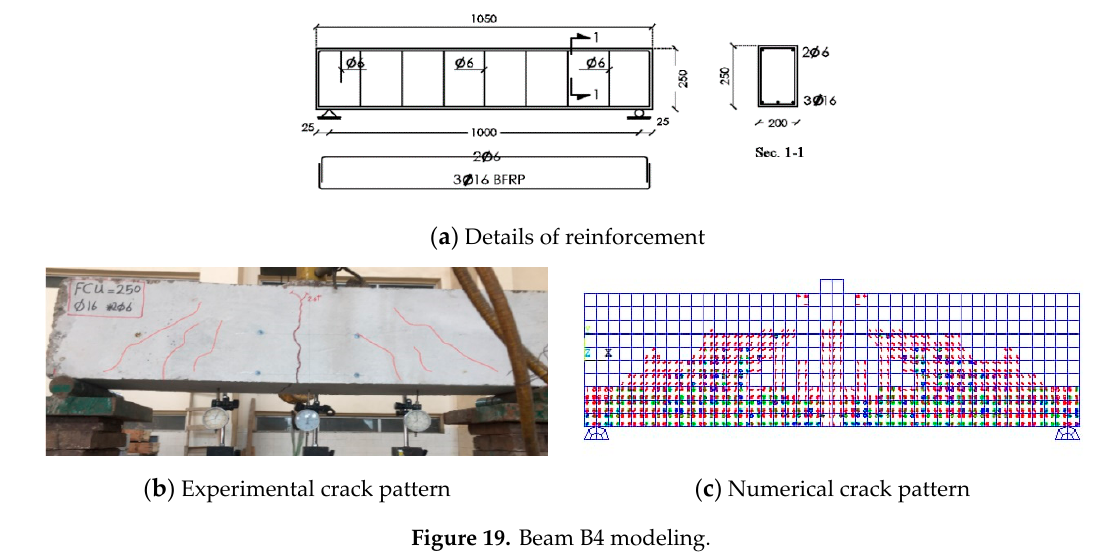
Figure 19. Beam B4 modeling.